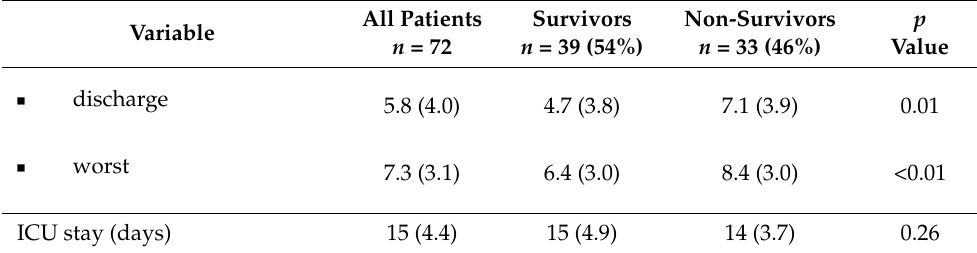
Table 1 legend: Data are given as n (%) or as mean (sd) as appropriate. Serum iron largest decrease: baseline value (day 1)—lowest value measured from day 7 to discharge. Serum ferritin largest increase: highest value measured from day 7 to discharge—baseline value (day 1). SOFA: Sequential Organ Failure Assessment Score. Serum iron levels were in the reference range or decreased on ICU admission and